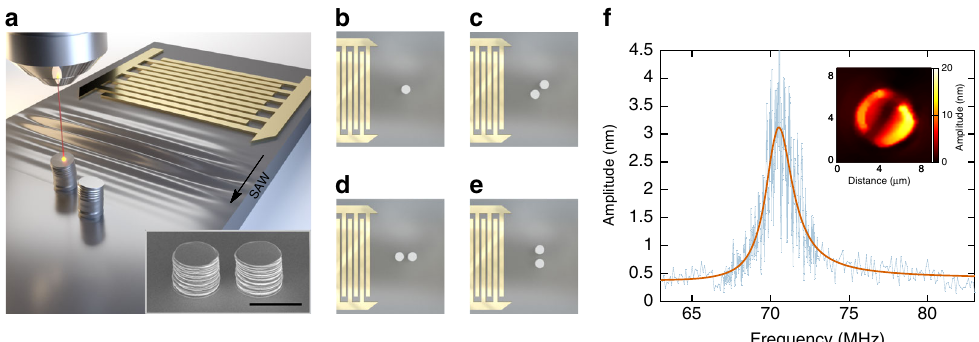
Fig. 1 Schematic of the sample and of the proposed measurement and excitation schemes. a The resonators are excited by surface acoustic waves launched using an interdigital transducer. The resonator motion is characterised by laser scanning heterodyne interferometry. A scanning electron microscope image of a pillar pair fabricated by IBID is depicted in the inset. The scale bar is 5 µ m. The response of a single pillar is fi rst investigated as a reference, following the excitation scheme reported in b. Three impinging SAW wave vector directions are then considered for excitation of the pillar pair, respectively corresponding to a diagonal c , a longitudinal d and a transverse e coupling scheme; the gap distance is set to either 1.5 µ m or 6 µ m. f Experimental frequency response of a single pillar, obtained by extracting the maximum of the out-of-plane amplitude of the displacement fi eld at the resonator surface out of 16 points encompassed within a pillar inner diameter. The light blue solid line correspond to data acquired every 10 kHz between 67 and 73 MHz and every 100 kHz outside this range. The red solid line corresponds to a fi tting of the experimental data with a Fano line shape. Inset: out- of-plane displacement fi eld map at the maximum amplitude ( f = 70.54 MHz). The scan area is 9 µ m × 9 µ m, with a step size of 200